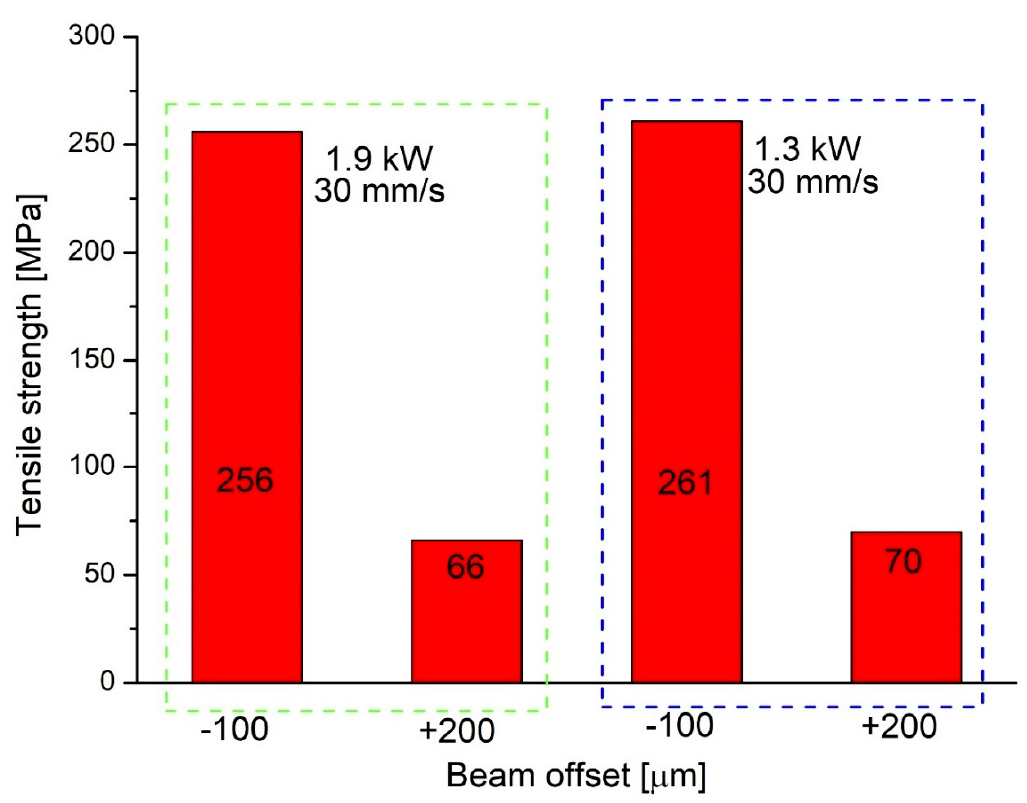
Figure 12. Influence of beam offset and laser power on weld strength.